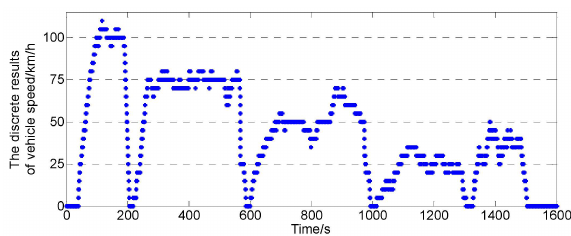
Figure 16. The discrete results of vehicle speed.